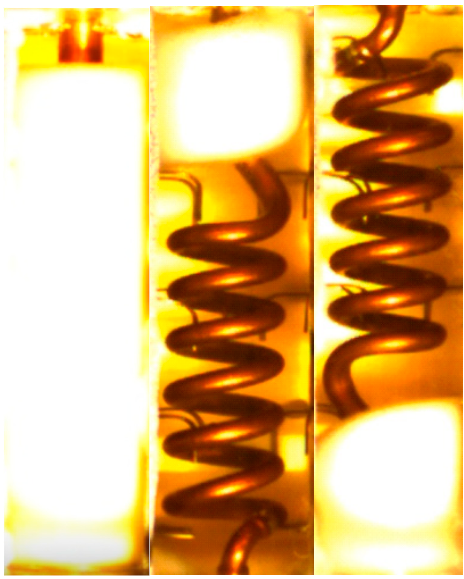
Figure 18. Melting front images for different geometry of storage units but for the same process time equal to 60 min and the same constant wall temperature condition ( Ts = 34 °C): at left for annular TES, at the middle for shell-and-coil TES with coil position at the bottom of the tank, at the right for shell-and-coil TES with coil position at upper of the tank.